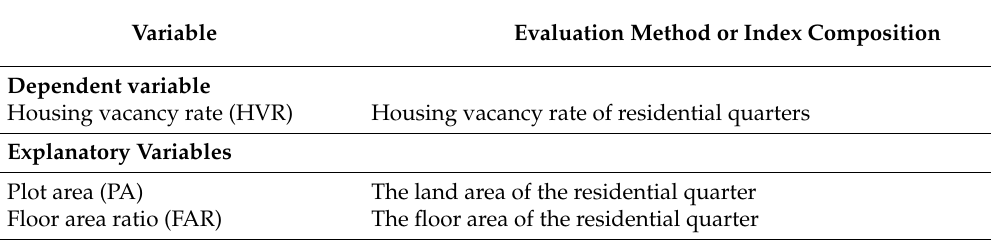
Table 1. Definitions and evaluation methods for the